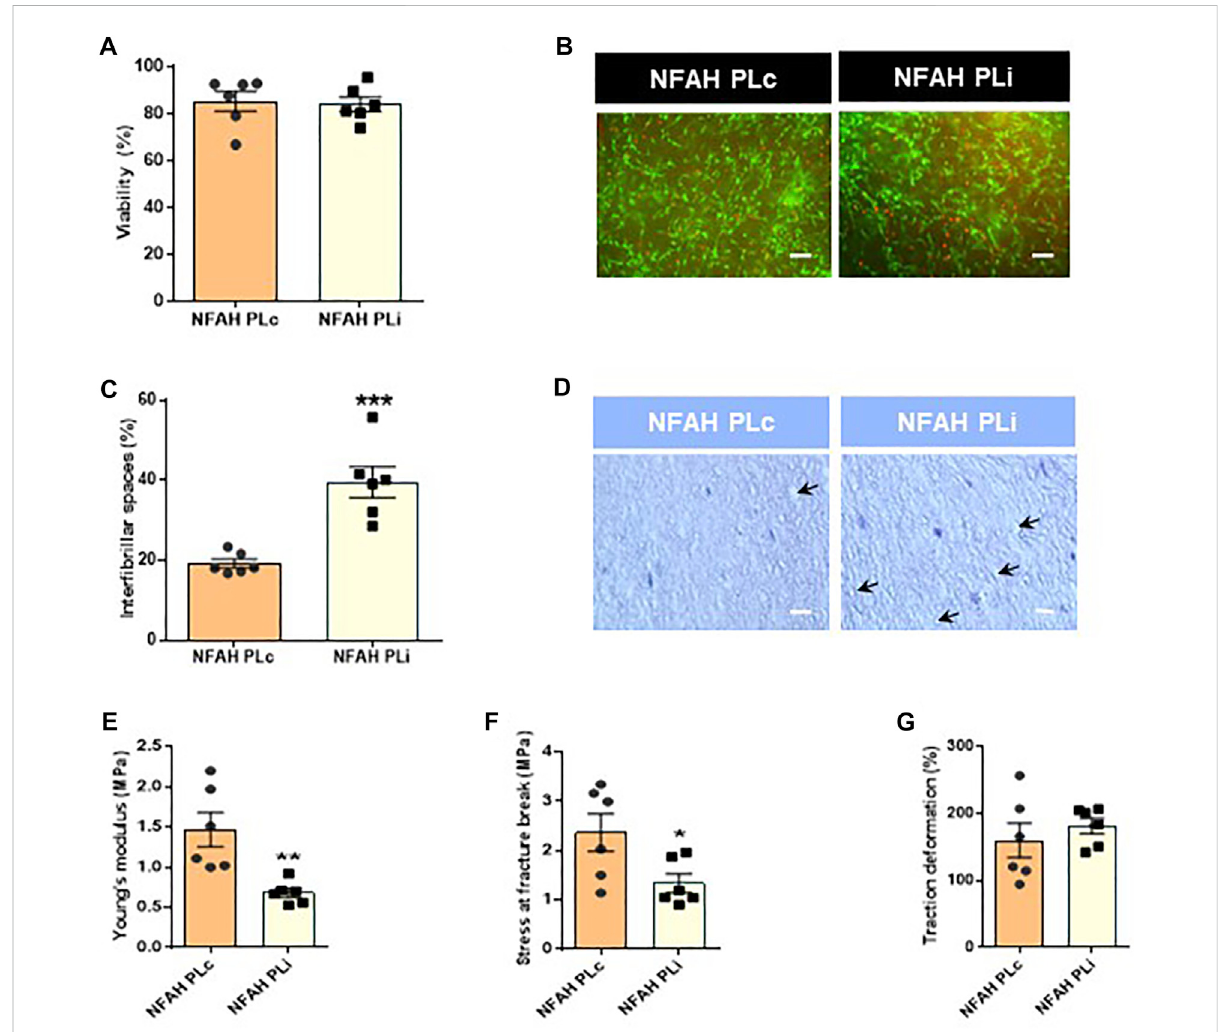
FIGURE 2 Structural and biomechanical characterization of nanostructured fi brin-agarose hydrogels. Bar graph representation of (A) percentage of cell viability and (B) LIVE/DEAD ® Assay staining of cellular NFAH (scale bar: 100 μ m). (C) Inter fi brillar spacing immediately after the nanostructuring process. (D) Representative hematoxylin/eosin staining of tissue sections of cellular NFAHs (scale bar: 100 μ m). Biomechanical analysis: Bar graph representation of (E) Young ’ s modulus, (F) stress at fracture-break, and (G) traction deformation. Data are shown as mean ± SEM. Arrows indicate inter fi brillar spacing. Six independent samples per group were analyzed. Two-tailed unpaired Student ’ s t -test: * p < 0.05; *** p <